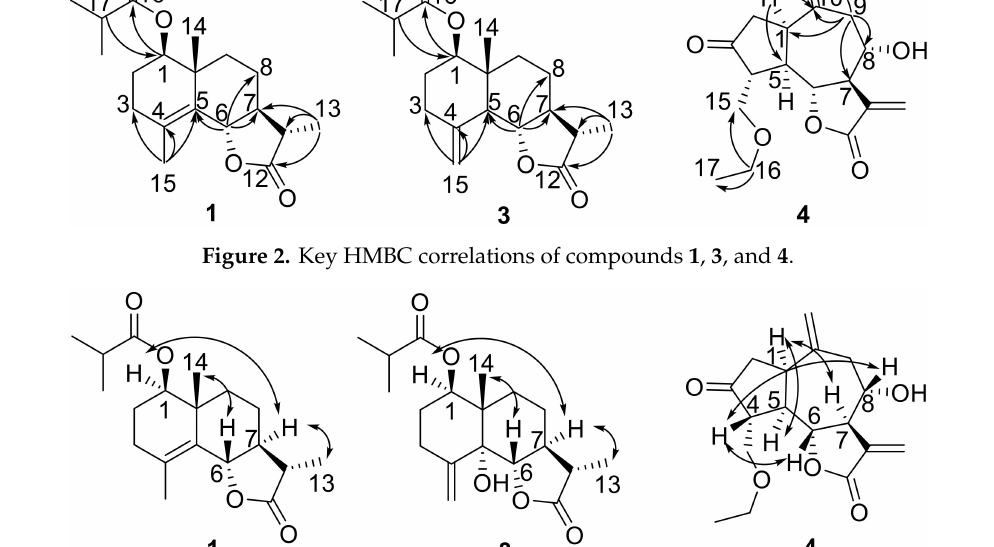
Figure 3. Key NOESY correlations of compounds 1 , 3 , and 4